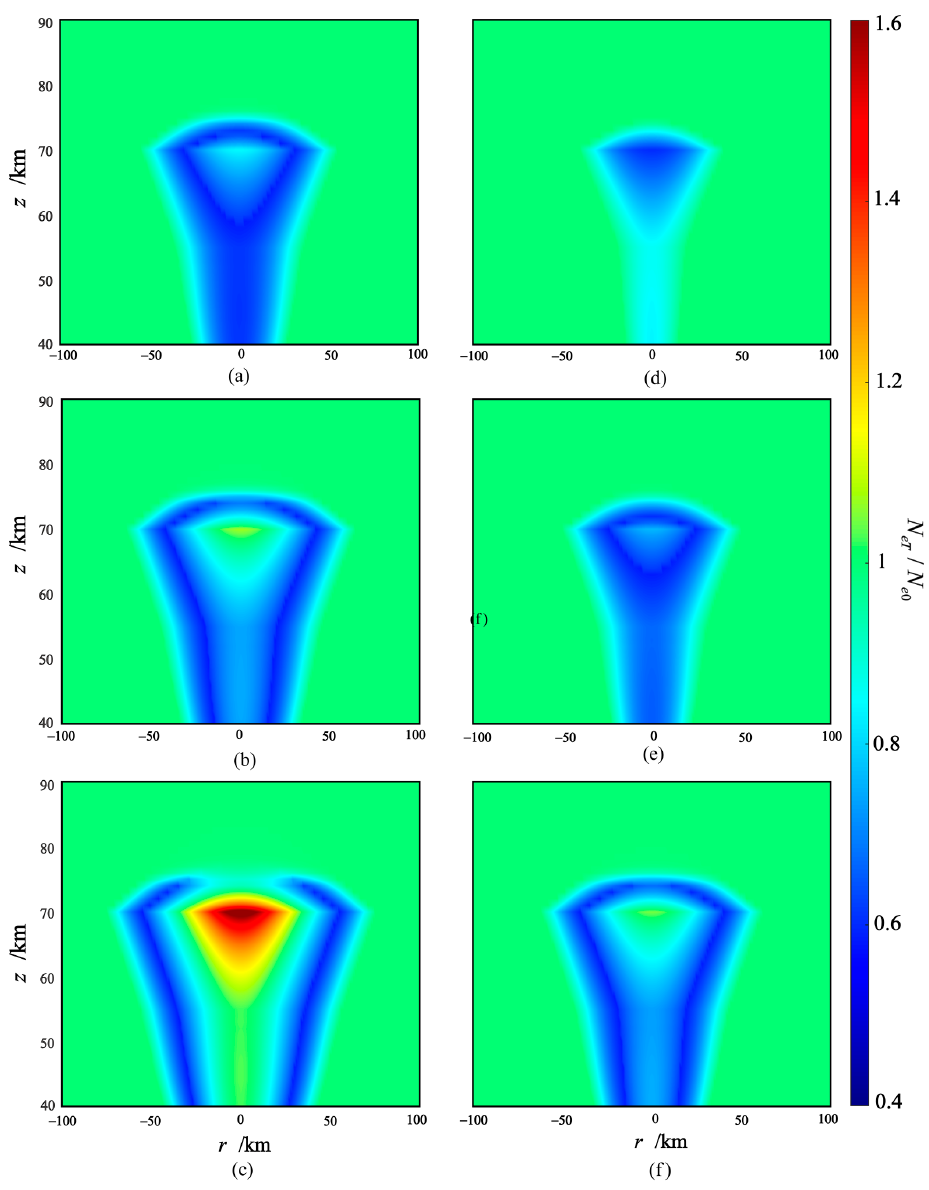
/ N N in the lower ionosphere 0 eT e N is the electron density in the eT N is the background electron 0 e